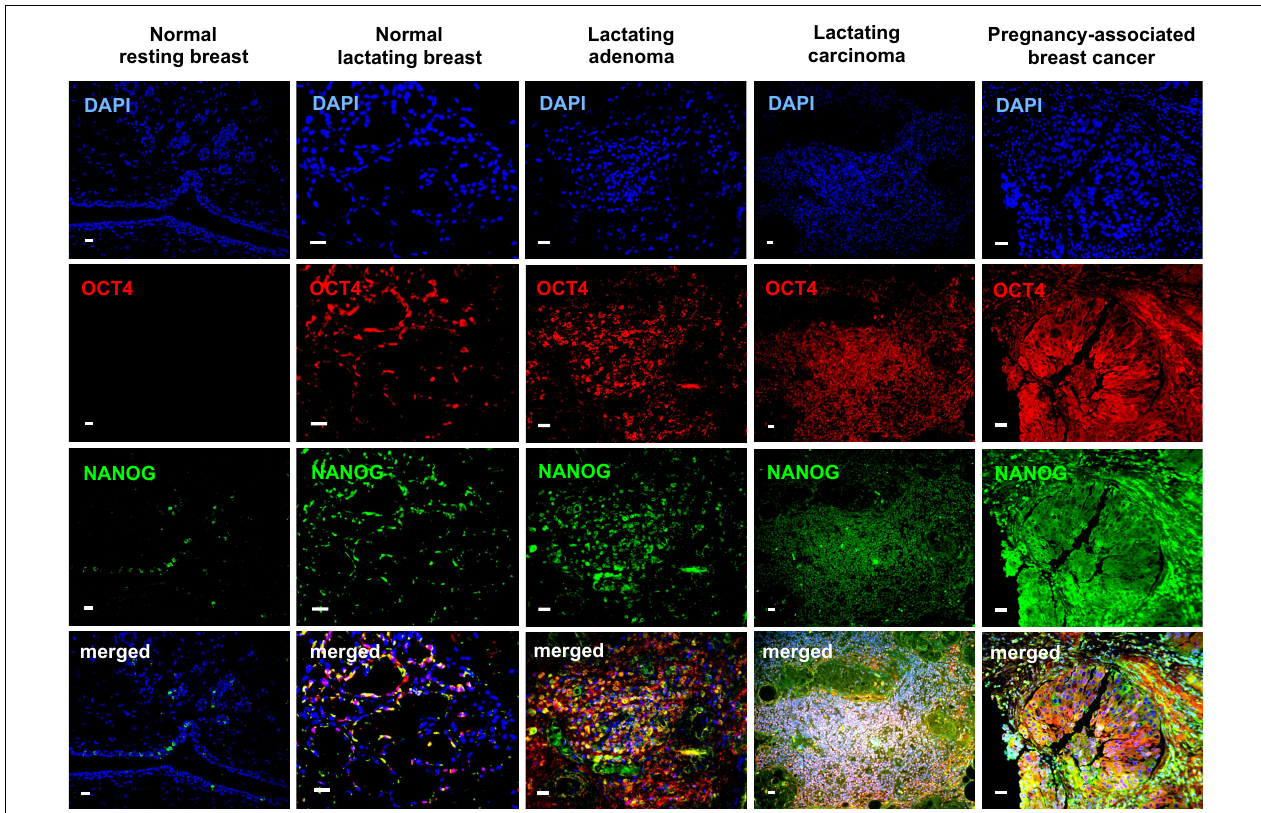
FIGURE 6 | Co-localization of OCT4 (red) and NANOG (green) in the normal lactating breast and in breast tumors with lactating features or associated with pregnancy and lactation. Scale bars: 20 µ m. Blue: DAPI stain for nuclei.